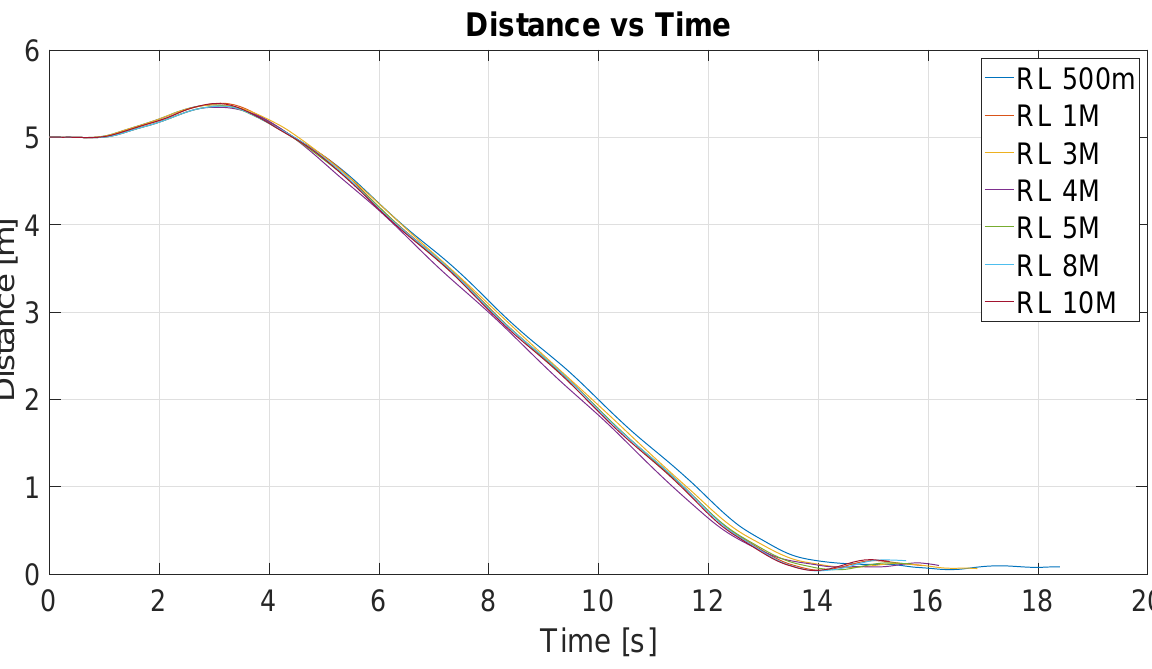
Figure 10. Distance vs. time of all